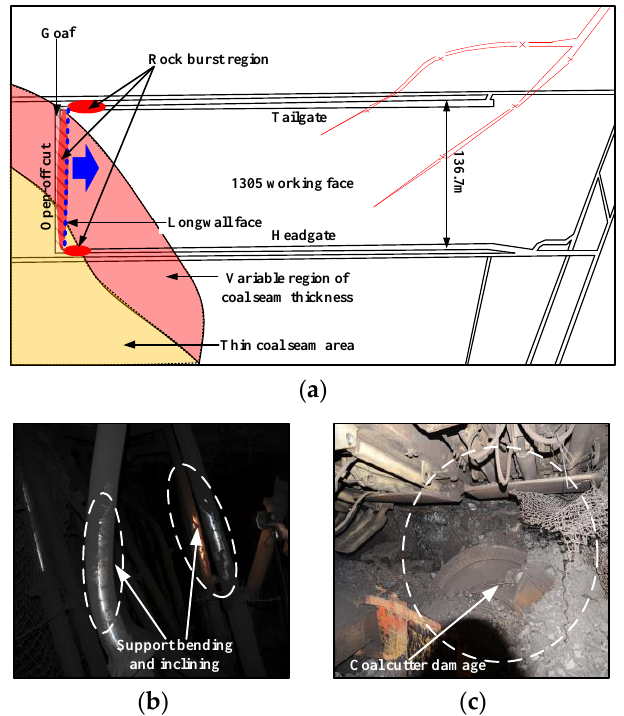
Figure 3. Rock burst region in the No. 1305 mining face and photos of the rock burst damage, ( a ) rock burst region, ( b ) roadway damage, ( c ) longwall face damage.